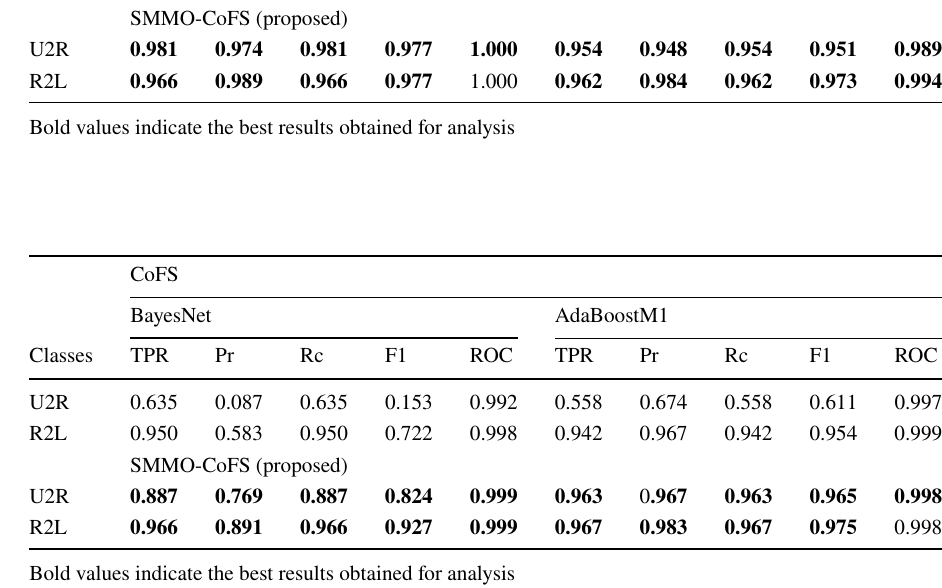
Table 5 Performance evaluation of SMMO-CoFS method in terms of TPR, Pr, recall, F 1 and ROC for U2R and R2L classes using random forest and J48 classifiers by comparing with collaborative feature selection (no data balancing)